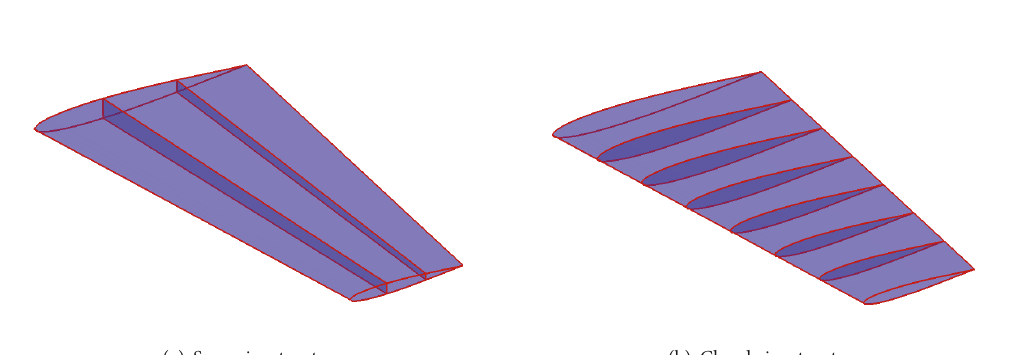
Figure 6: The spanwise and chordwise structural layout scheme of